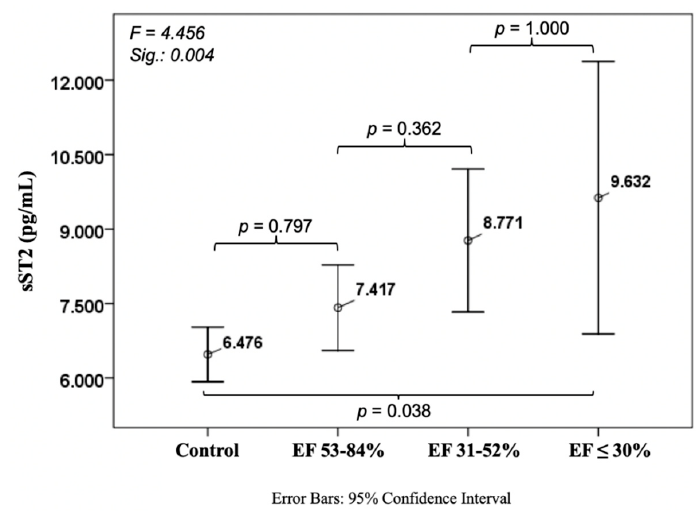
Figure 4. Course of soluble suppression of tumorigenicity 2 (sST2) in ischemic heart disease. J. Clin. Med. 2019 , 8 , x FOR PEER REVIEW